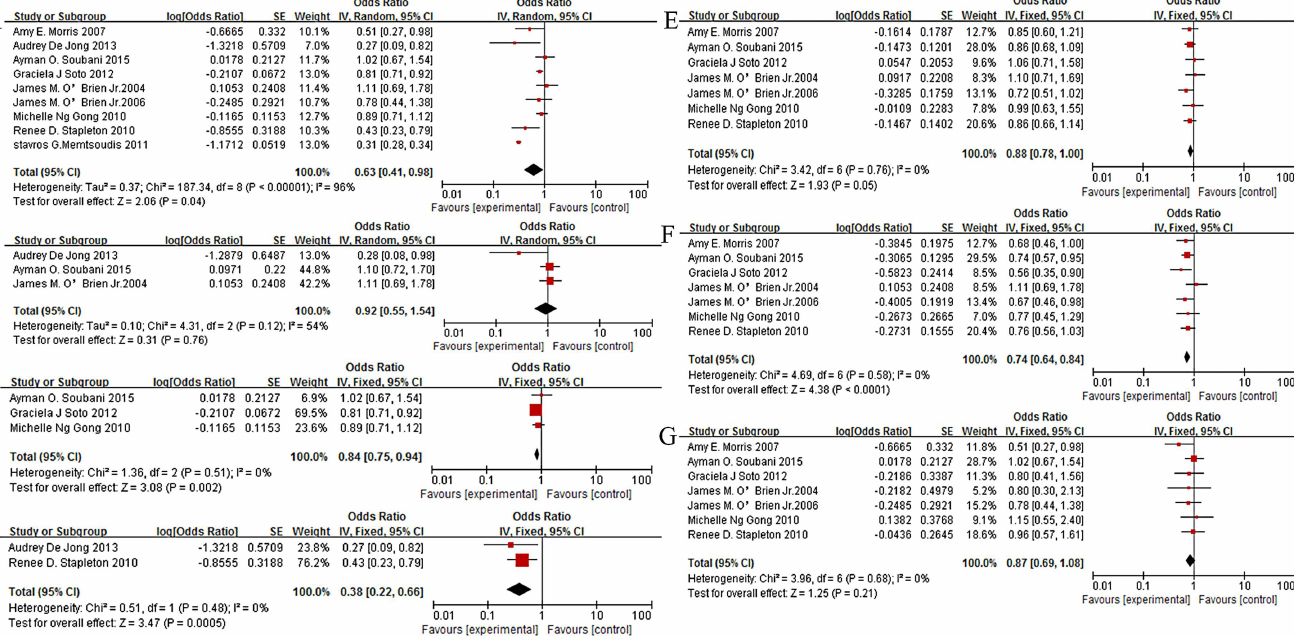
PLOS ONE | DOI:10.1371/journal.pone.0163677 September 29,